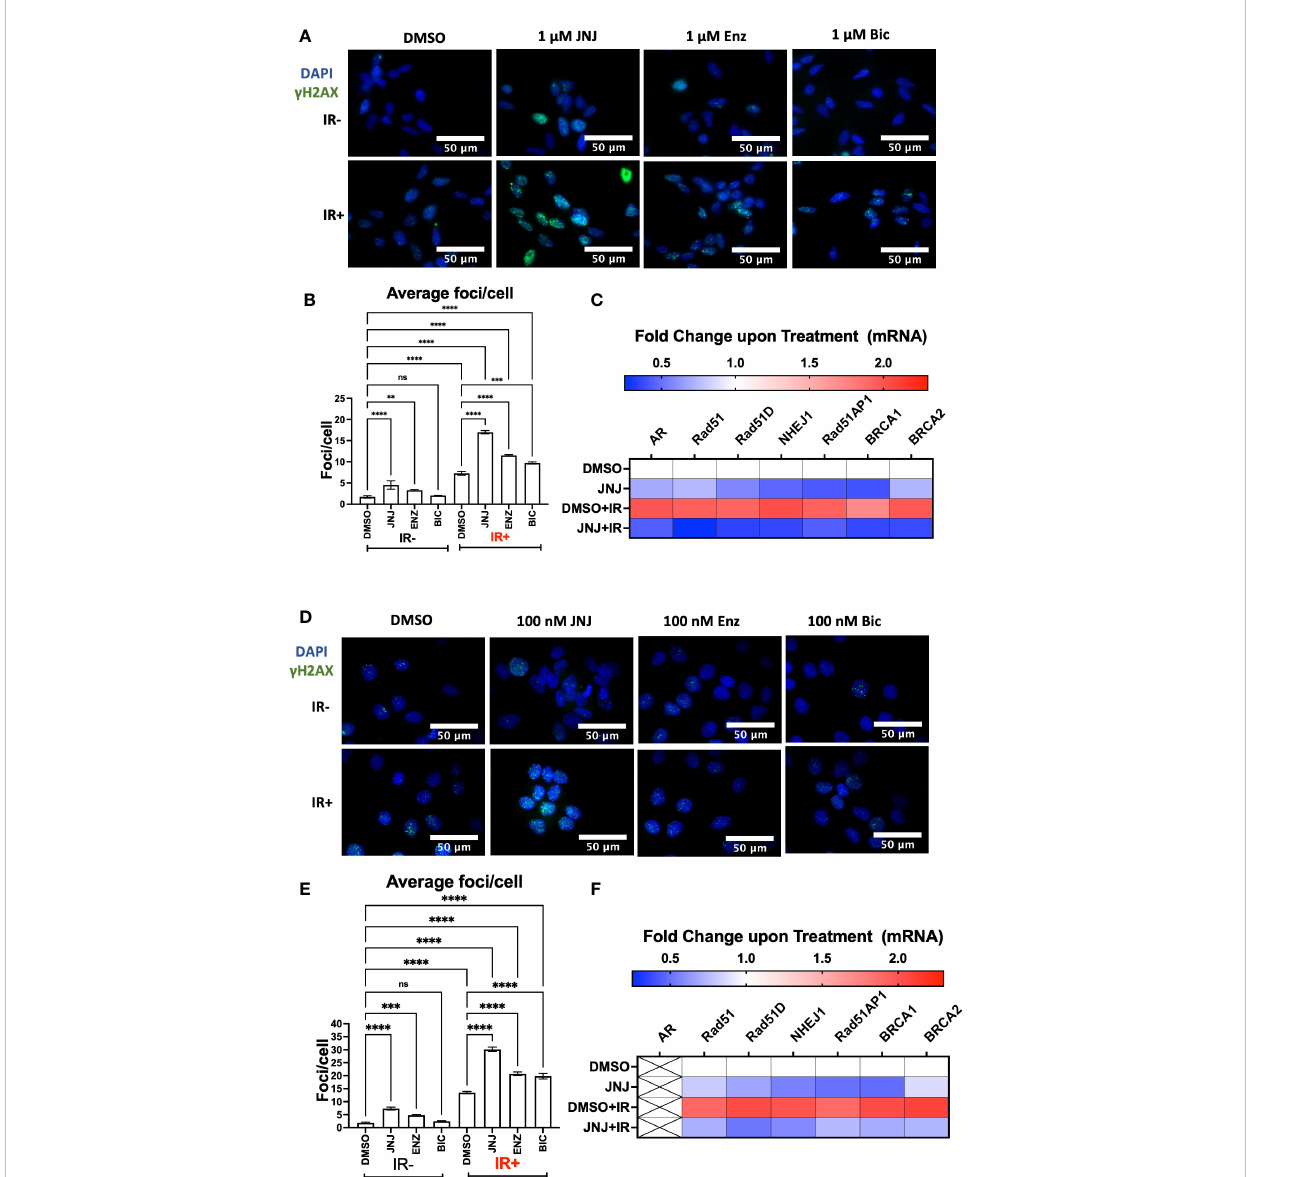
FIGURE 3 JNJ-64619178 impairs radiation-induced DSBs repair in both AR+ & AR- prostate cancer cells by targeting transcriptional activation of these genes involved in NHEJ and HR. (A) Representative fl uorescence immunocytochemistry images showing double-stranded DNA breaks ( g H2AX foci) images post 6hrs of 2Gy IR in LNCaP Cells. (B) Quanti fi cation of average DNA breaks per cell from (A, C) Histogram showing the change in NHEJ and HR genes mRNA at transcriptional level post 6hrs of 2Gy IR in LNCaP Cells. (D) Representative fl uorescence immunocytochemistry images showing double-stranded DNA breaks ( g H2AX foci) images post 6hrs of 2Gy IR in DU145 Cells. (E) Quanti fi cation of average DNA breaks per cell from (D, F) Histogram showing the change in NHEJ and HR genes mRNA at transcriptional level post 6hrs of 2Gy IR in DU145 Cells. For statistical analysis